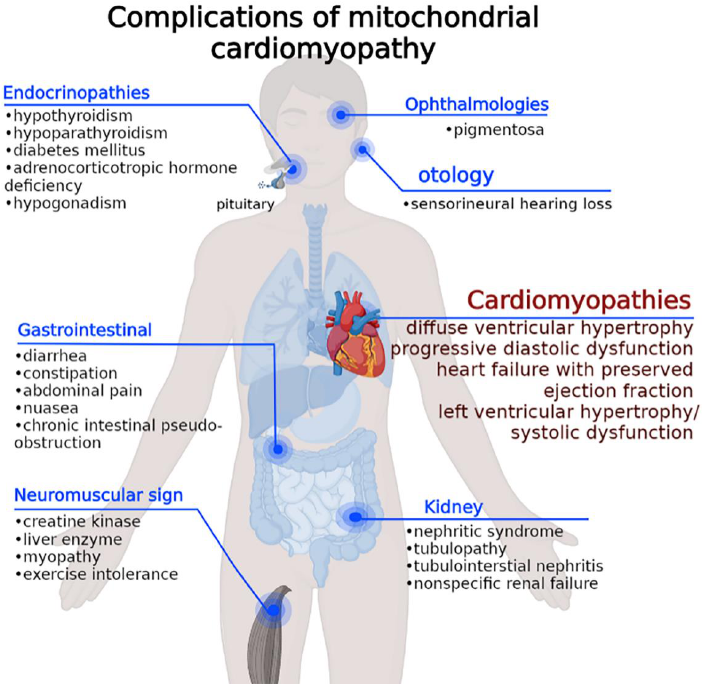
Figure 1. Common complications of MCM. MCM patients can present a range of systemic multiorgan symptoms. The spectrum of tissues involved varies between the mutation (mtDNA or nDNA), heteroplasmy, and age of onset and thus makes it difficult to predict disease progression.